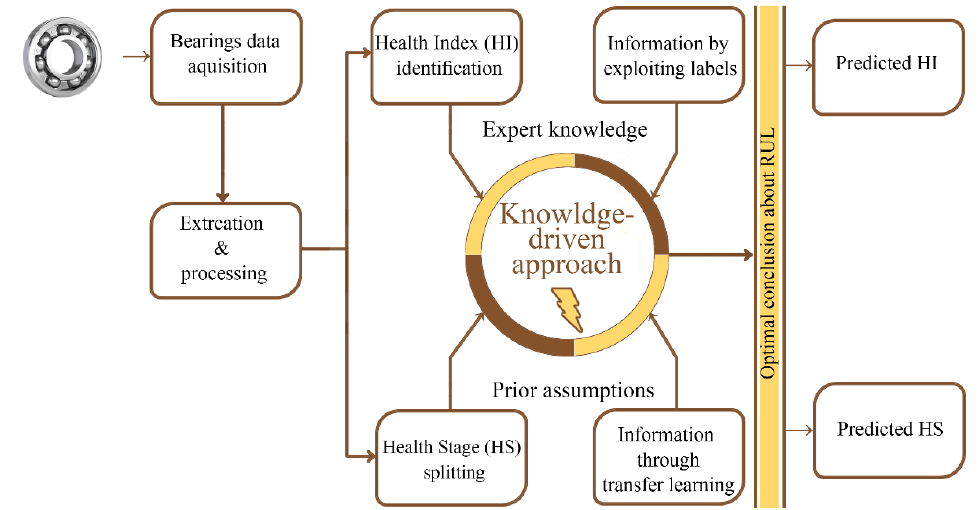
Figure 5. Adopted methodology during health assessment model